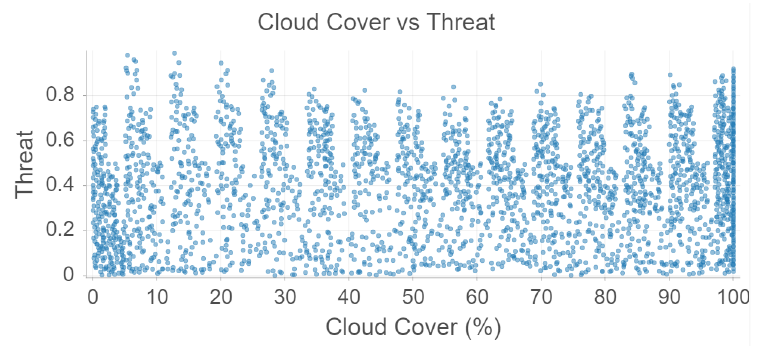
Figure 7. Cloud Cover and Threat analysis using Random